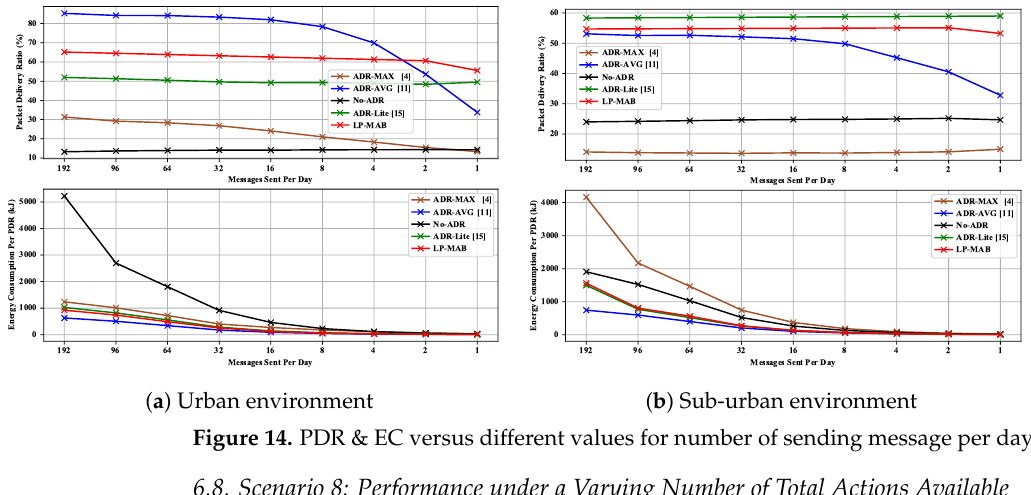
Figure 14. PDR & EC versus different values for number of sending message per day in Scenario